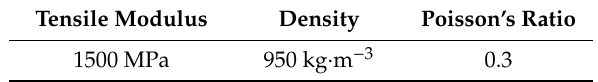
Table 4. Properties of L-PBF Nylon-12 used for modelling lattice structures in this work [59].